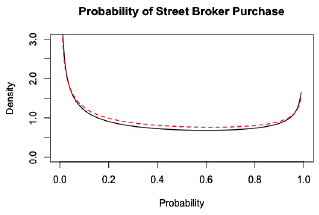
Figure 6. Distribution of the probability of purchasing via a street broker, conditional on successfully obtaining heroin in the market. The black line represents the density of the probability of a street broker purchase across all successful customer market trips within each 1-hour interval of market activity based on 100 simulations of the market from days 180 to 365. The dashed red line represents a fitted distribution, which is a Beta (0.61,0.76) distribution.